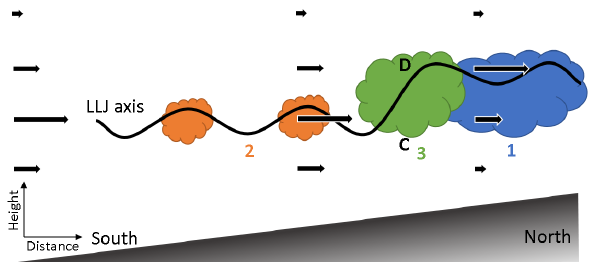
Figure 9. Schematic illustration of the processes contributing to cloud formation, i.e. orographically induced lifting (1), gravity waves (2) and horizontal convergence and upward motion upstream of existing clouds (3). Grey shading marks the terrain, arrows indi- cate the horizontal flow and the black line illustrates the height of the LLJ axis. C and D mark areas with horizontal convergence and divergence, respectively, related to process